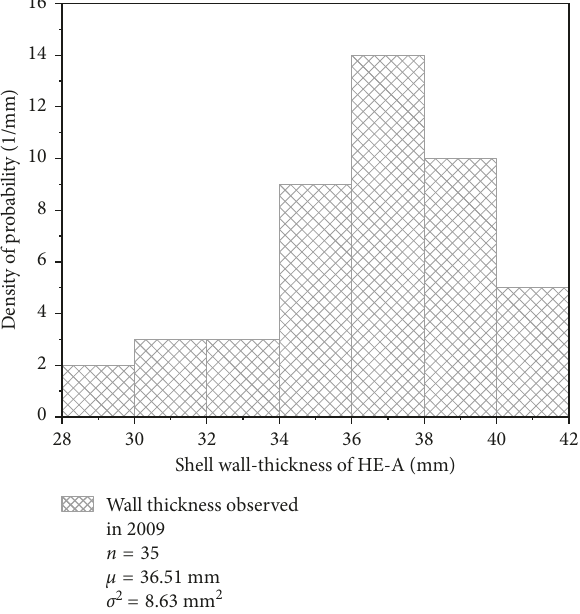
Figure 6: Wall Thickness observed for HE-A in 2009.